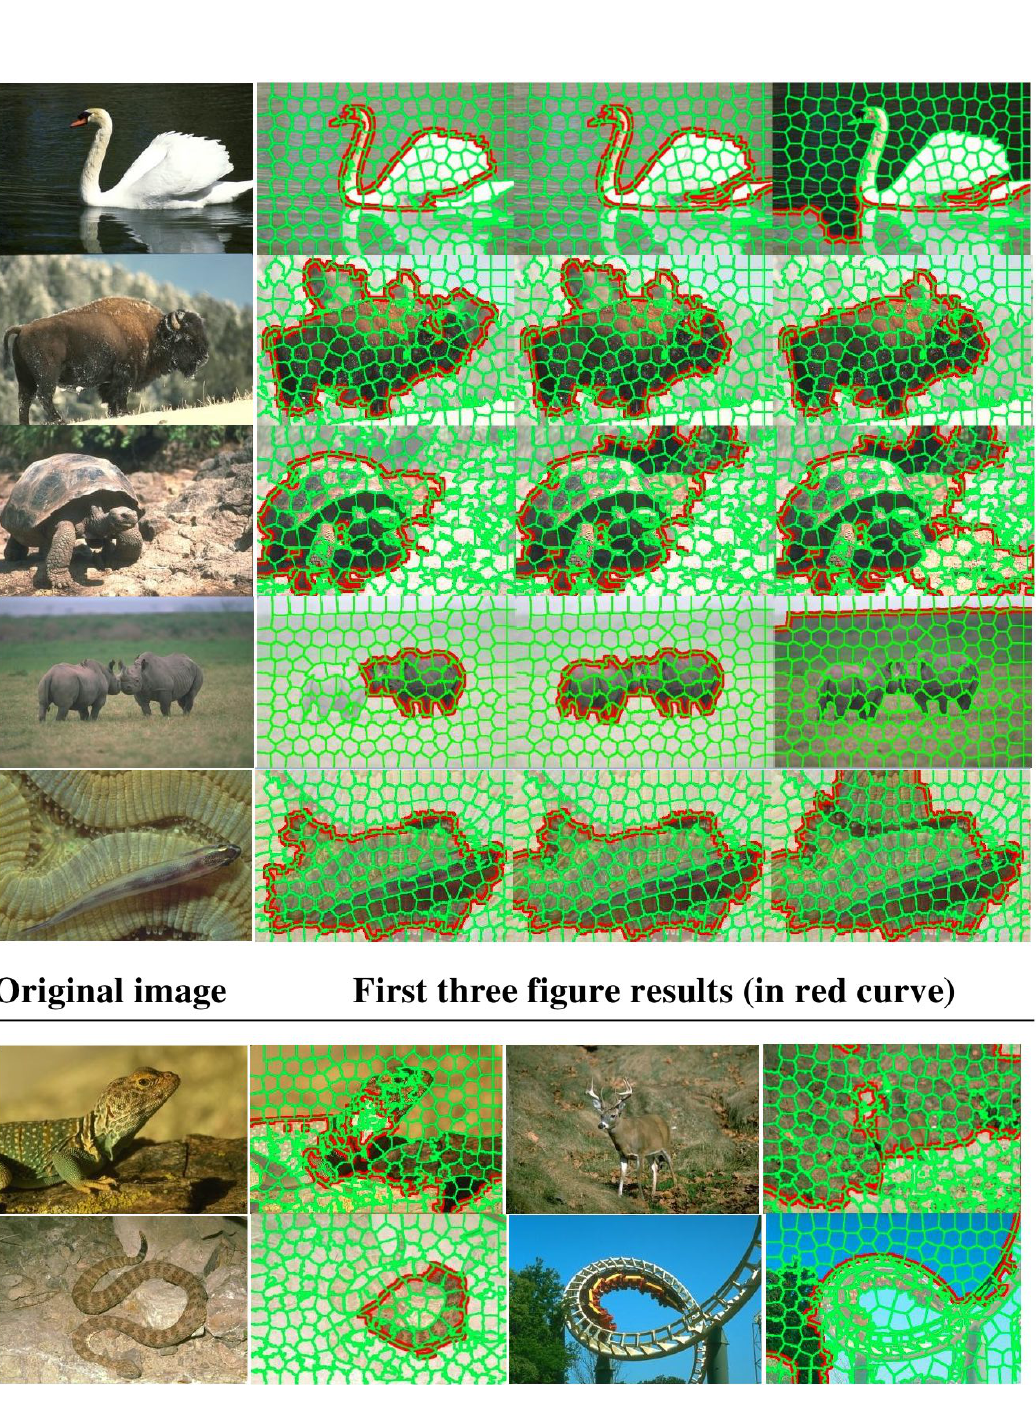
Figure 5: Segmentation examples of BSDS500 Test images. Top 5 rows: original image and first 3 figure segmentation results (the red figure boundary overlays with the superpixel segmentation image for visualization). Bottom 2 rows: typical failure